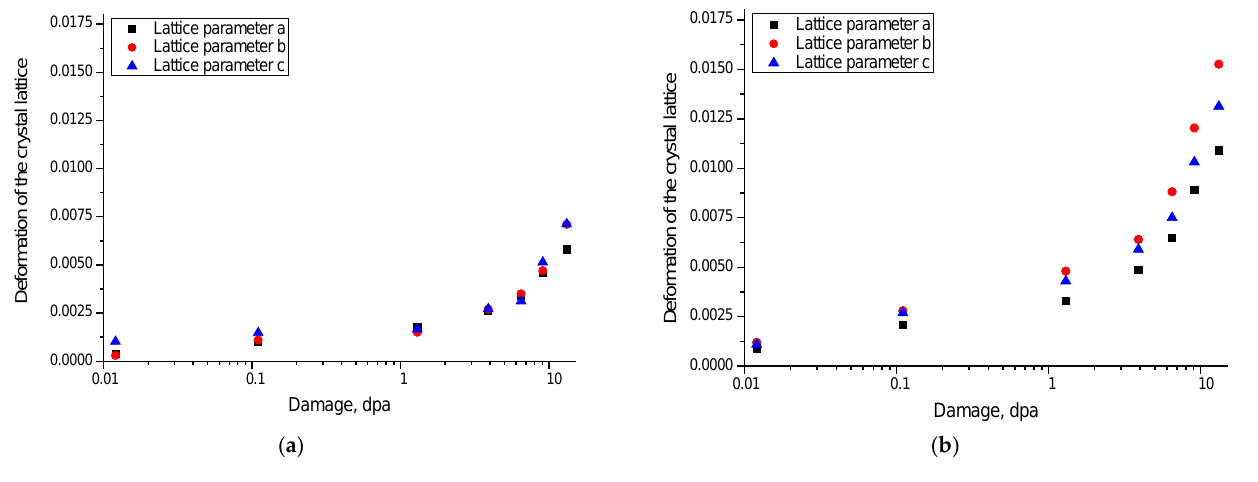
Figure 3. Results of deformation distortions of the crystal lattice parameters for the Li 2 ZrO 3 mono- clinic phase depending on the irradiation dose (displacement values are presented on a logarithmic scale): ( a ) Li 2 ZrO 3 /LiO ceramics; ( b ) Li 2 ZrO 3 ceramics.